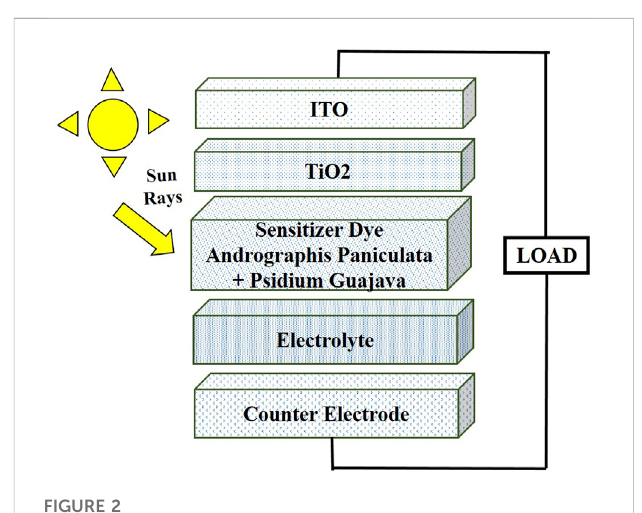
Schematic sectional view of the proposed